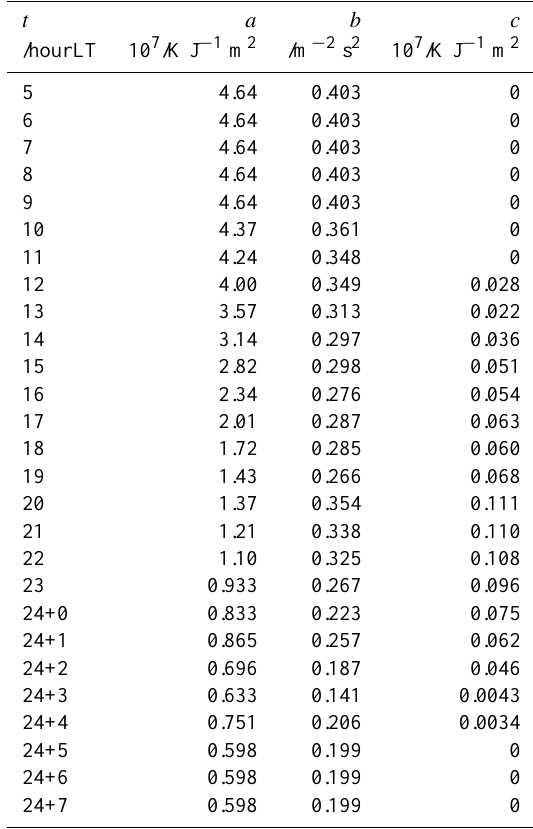
Table A1. Coefficients of the warming model, Eq.